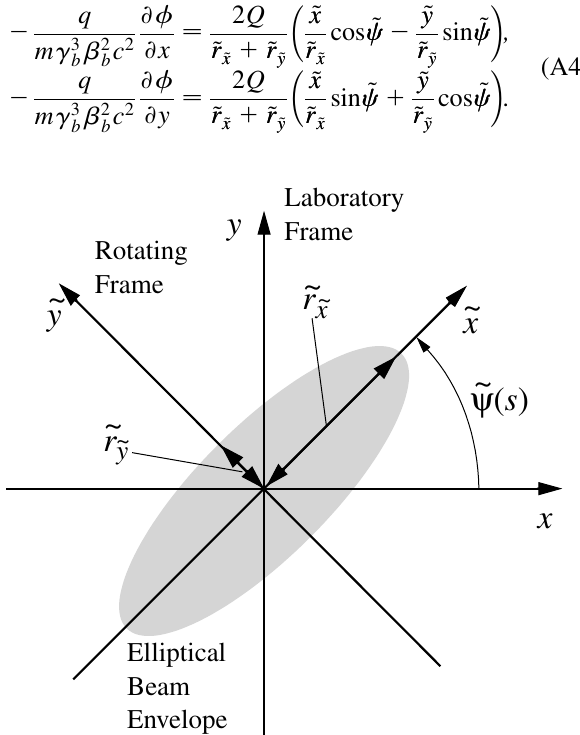
FIG. 21. Solenoidally focused elliptical envelope beam with principal axis radii ~ rr axes that are rotated by an angle ~ (cid:3) s (cid:4) relative to the laboratory